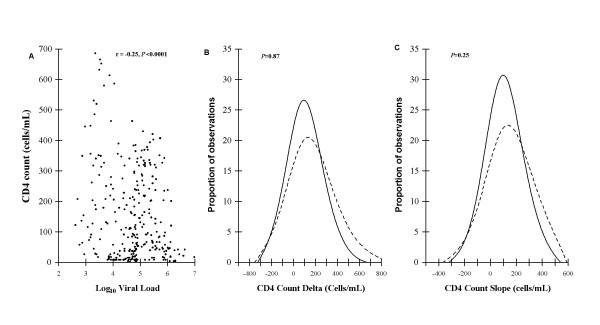
Scatter plot of the absolute CD4 count (cells/μl) and corresponding HIV RNA viral load (log10 copies/ml) for the subset of patients (n = 30) who did not ever achieve virological suppression during ART (A). The distributions of ΔCD4 counts (B) and CD4 cell count slopes (C) of this group are compared with that of patients who achieved and maintained virological suppression throughout the study period (n = 151).